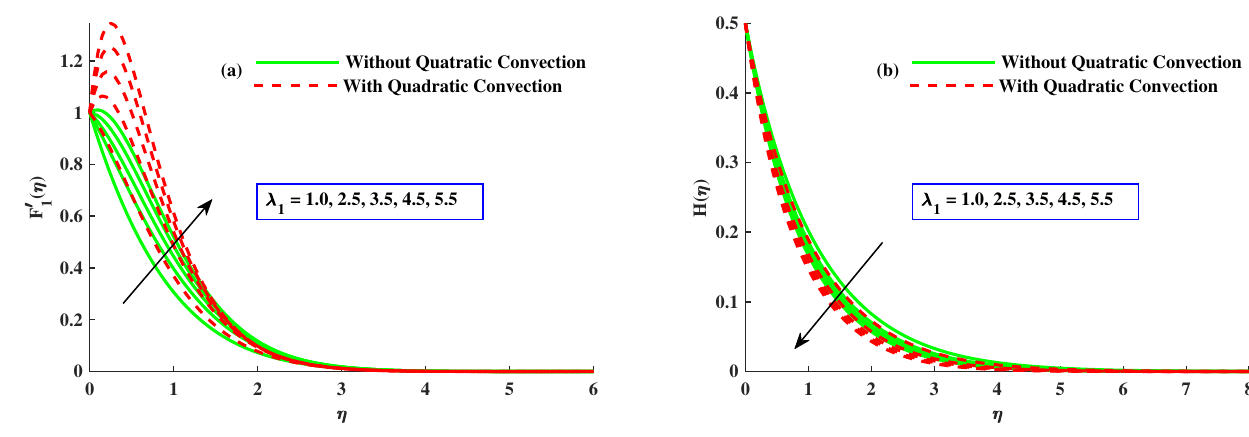
Figure 5. The influence of λ 1 on the F 1 (cid:48) ( η ) and H ( η )